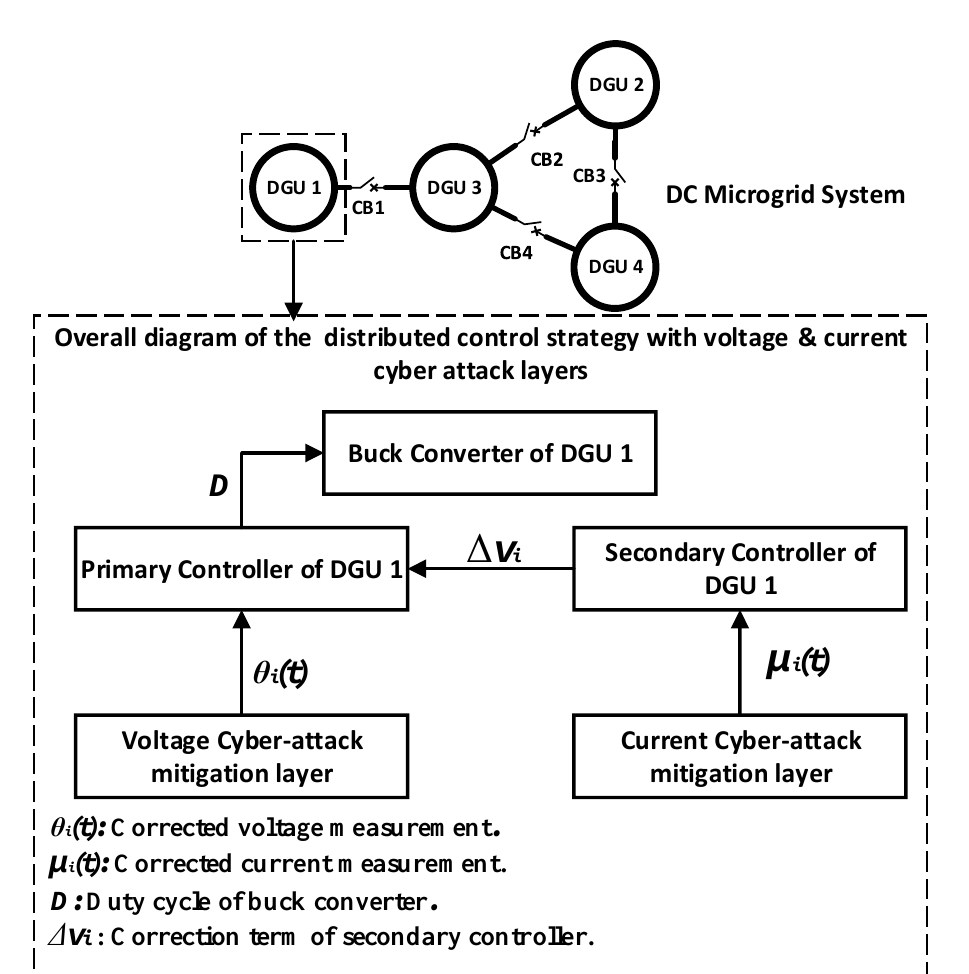
Figure 6. Overall system with the distributed control strategy blocks for a single DGU.